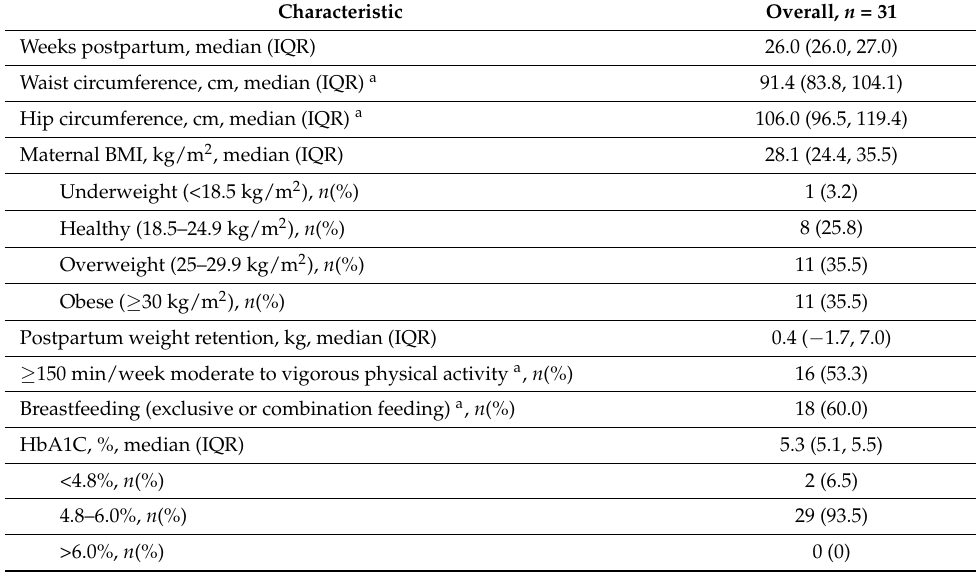
Table 3. Participant characteristics at 6-months